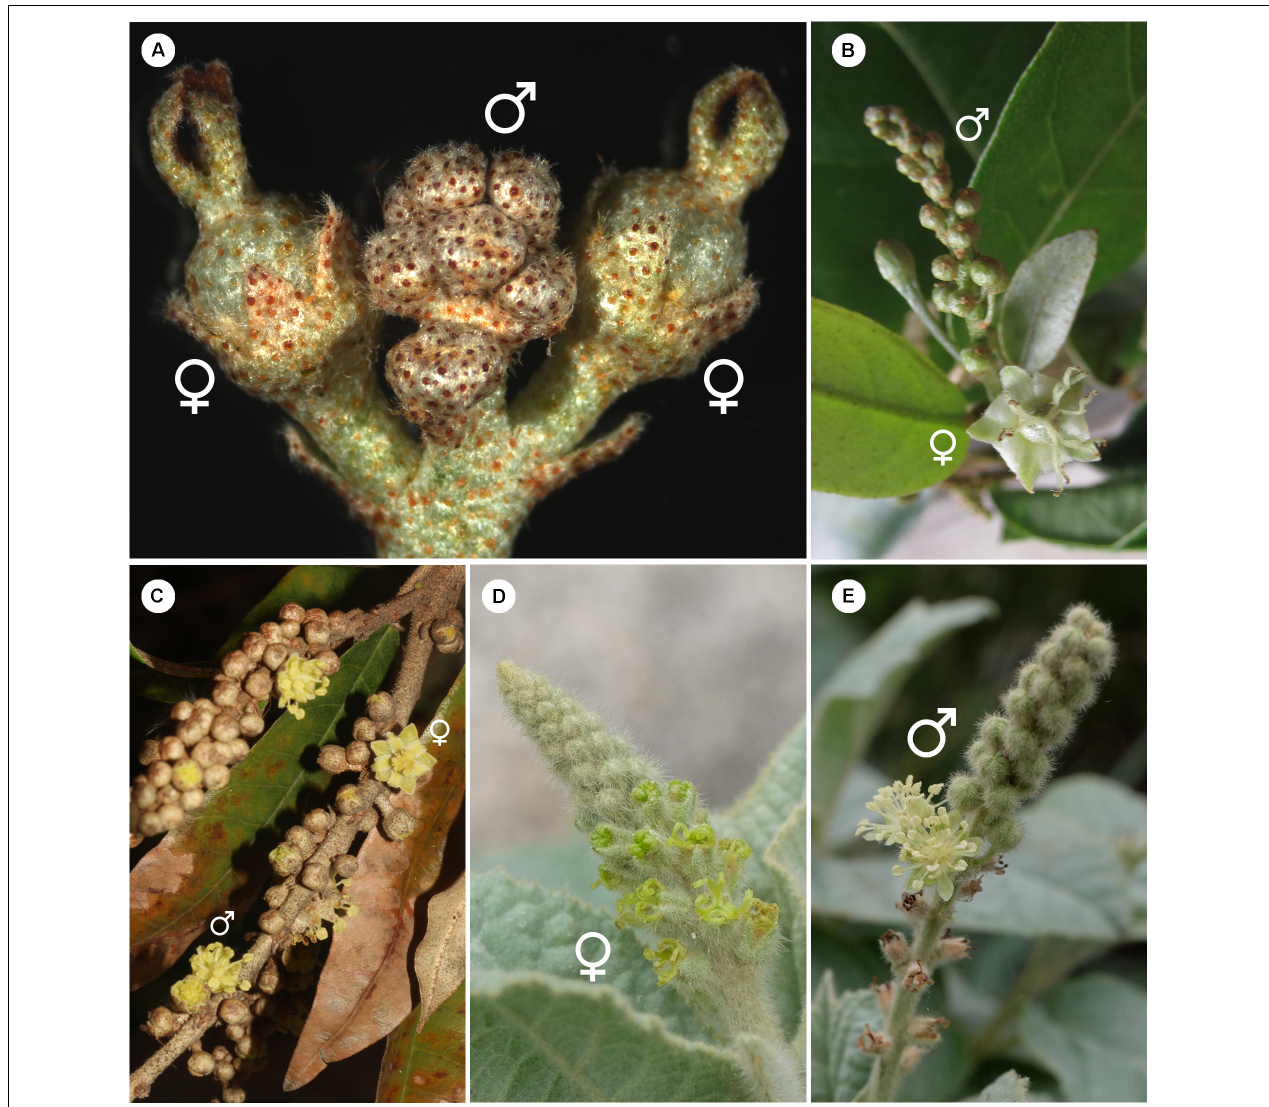
FIGURE 1 | Inflorescence of Croton with/without petals in pistillate flower (A) Inflorescence of C. alabamensis showing blooming pistillate flowers while staminate flowers are still closed. (B) Inflorescence of C. schiedeanus with long-pedicellate pistillate flower on the proximal part and many staminate flowers on the distal part. (C) Inflorescence of C. gratissimus , an African species with petals in pistillate flowers. (D) Inflorescence of C. chilensis showing pistillate stage. (E) Inflorescence of C. chilensis in the staminate stage (two open staminate flowers).